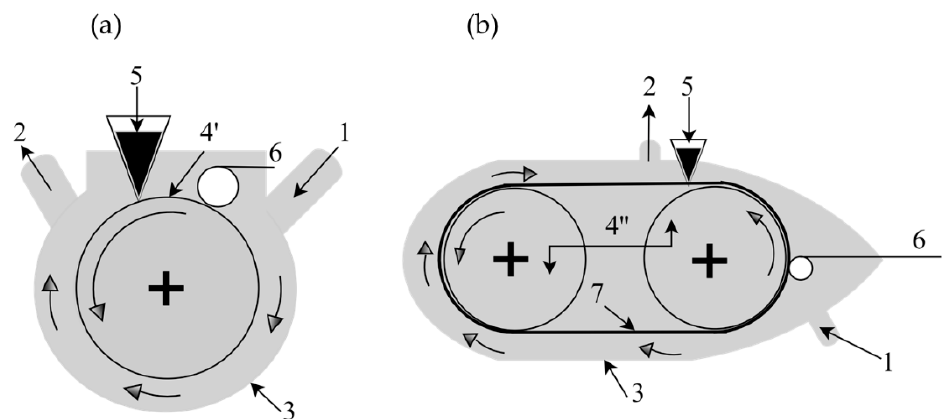
Figure 10. Schematic representation of the front ( a ) and cross ( b ) sections of a film production machine using the solvent spreading and evaporation technique: (1) air inlet; (2) air outlet; (3) external container; (4 ′ ) inner drum; (4 ′ ’) pulleys; and polymer spreader; (5) removed film; (6) roller; (7) moving belt.